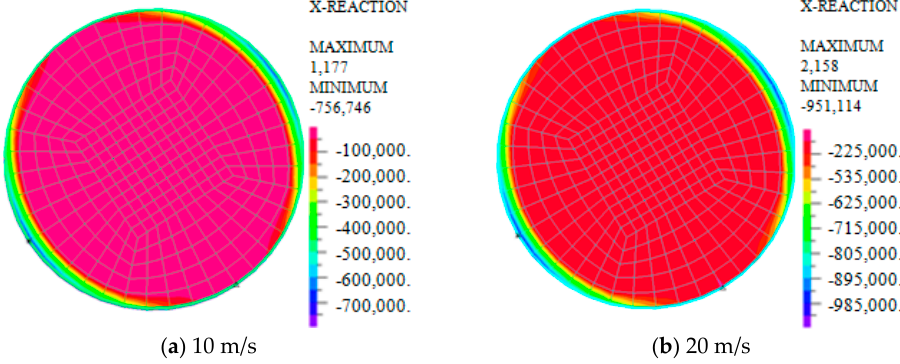
Figure 11. E ff ect of wind speed on tank base shear force (unit: N). Figure 11. Effect of wind speed on tank base shear force (unit: N). Figure 11. Effect of wind speed on tank base shear force (unit: N). Figure 11. Effect of wind speed on tank base shear force (unit: N). Table 3. E ff ect of wind speed on absolute maximum dynamic Table 3. Effect of wind speed on absolute maximum dynamic responses Table 3. Effect of wind speed on absolute maximum dynamic responses Table 3. Effect of wind speed on absolute maximum dynamic responses Wind Speed Wind Speed